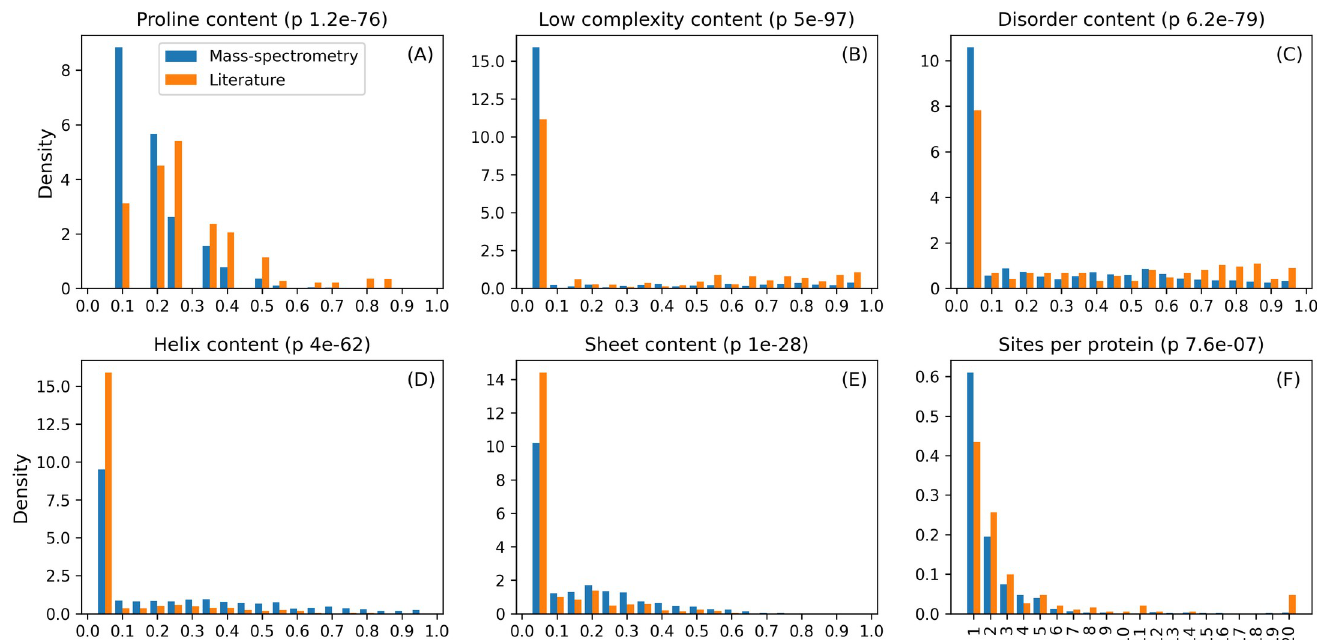
Fig 5. Features distribution for MS and Literature sites. Content refers to the fraction of residues in the site sequence associated with a given feature. Density refers to the fraction of proteins in the dataset with a given number of